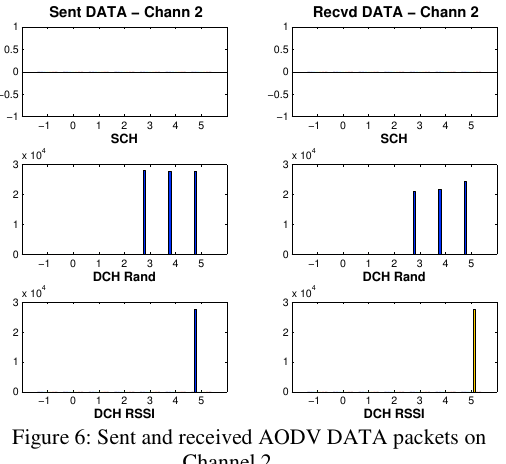
Figure 6: Sent and received AODV DATA packets on Channel 2